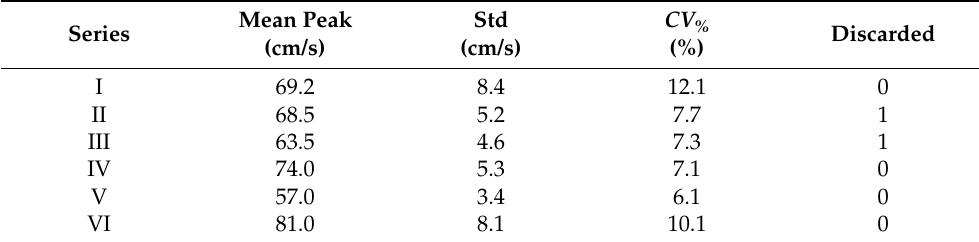
Table 7. Velocity repeatability on